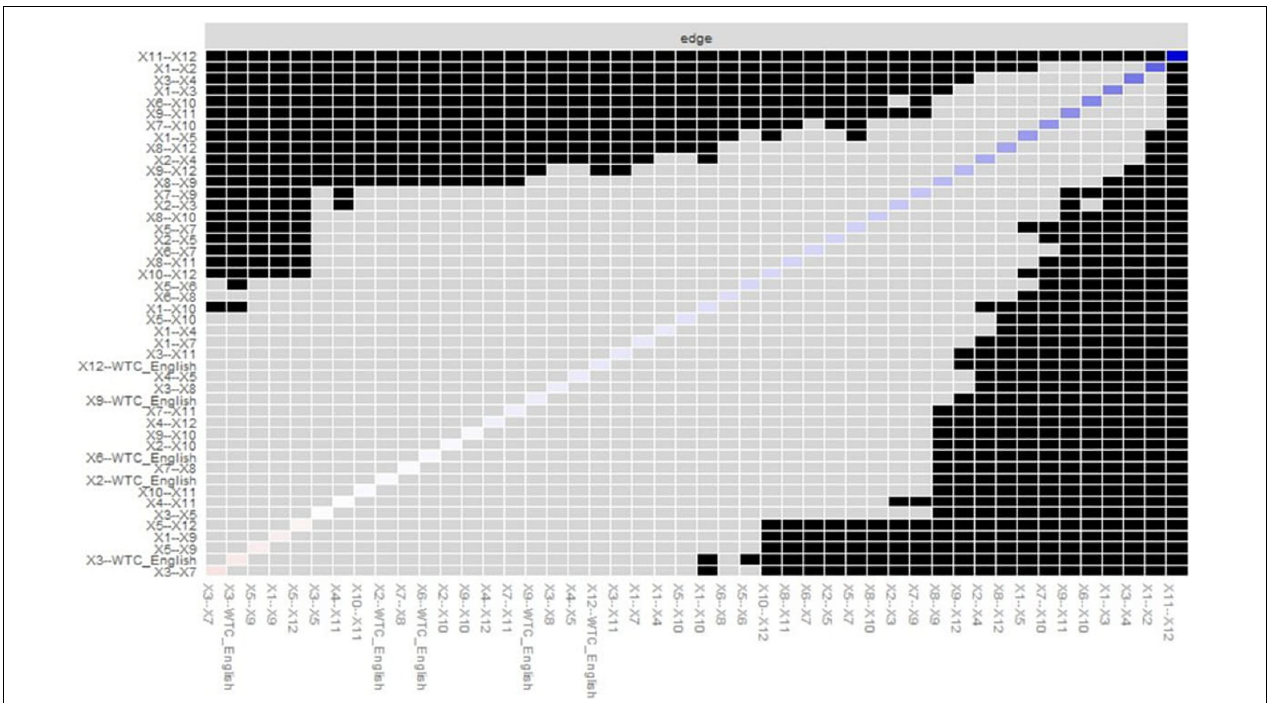
FIGURE 8 | Bootstrapped differences ( α = 0.05) between edge-weights that were non-zero in the estimated network. Gray boxes indicate edges that do not differ significantly from one another. Black boxes indicate edges that differ significantly from one another. Colored boxes correspond to the colors of the edges in Figure 4